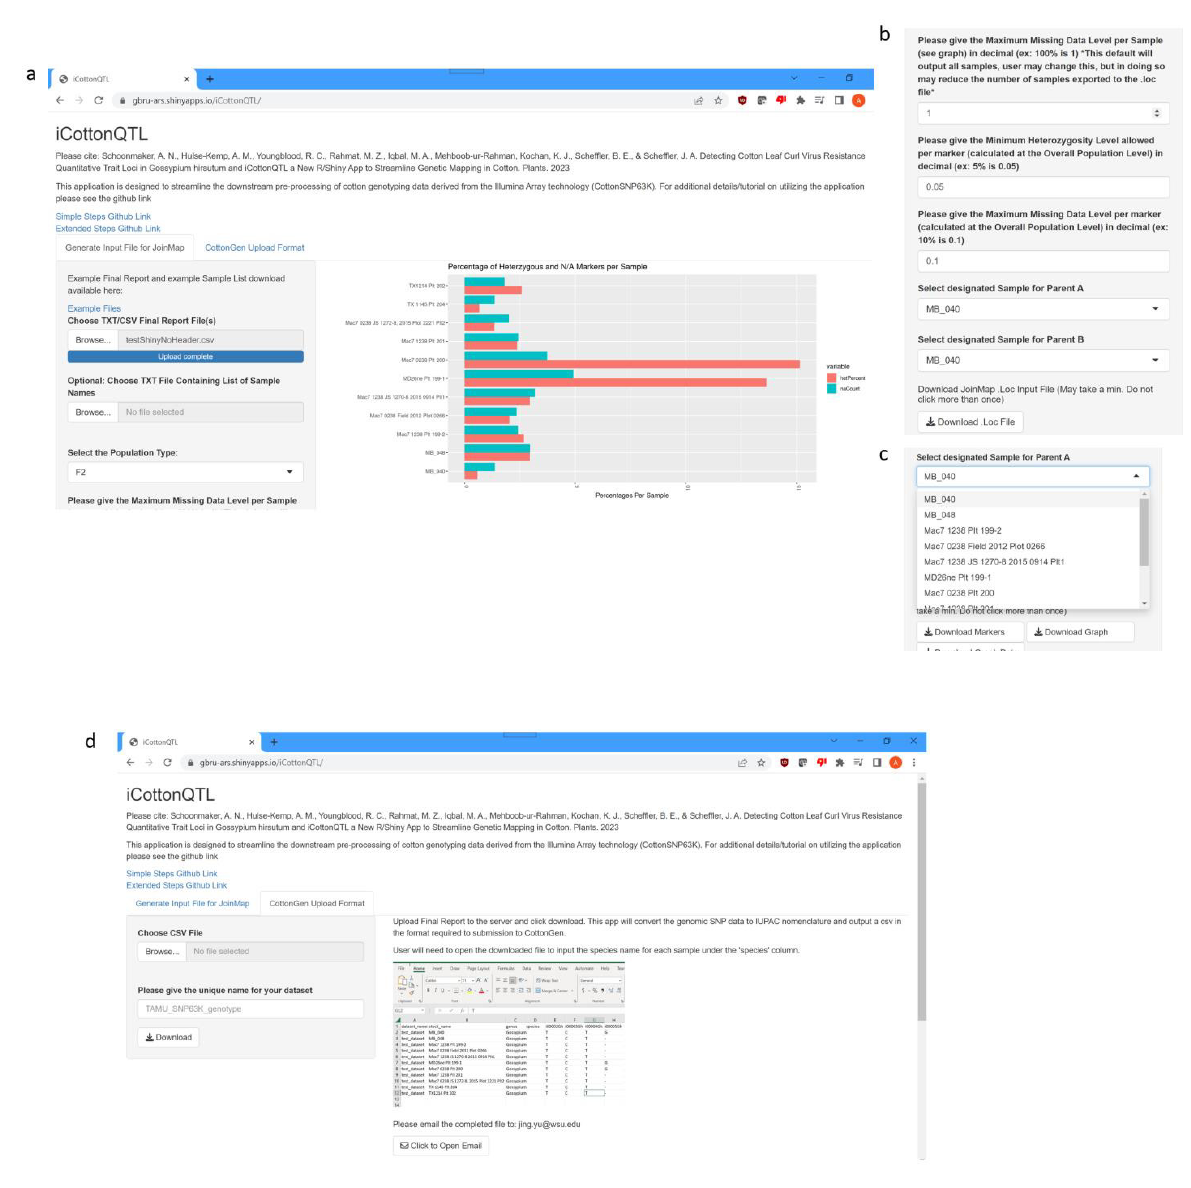
Figure 5. Screenshots of the iCottonQTL R/Shiny App. The application is available at https://gbru- ars.shinyapps.io/iCottonQTL/ (accessed on 21 February 2023). ( a ) Screenshot the first tab of the